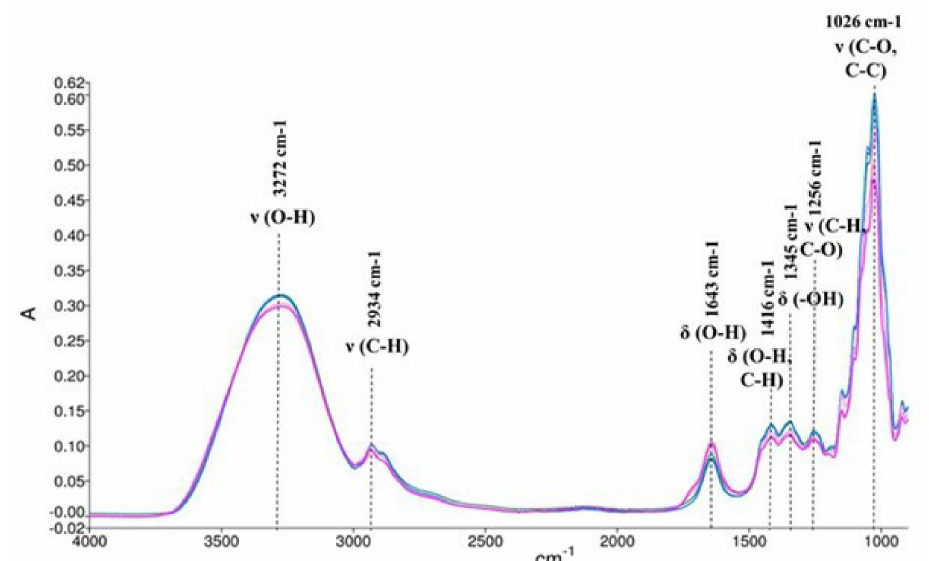
Figure 4. FTIR spectra curve and identified functional group region for Trigona honey (pink) and Apis honey (blue), x-axis: wavelength and y-axis: Absorbance. Reprinted with permission